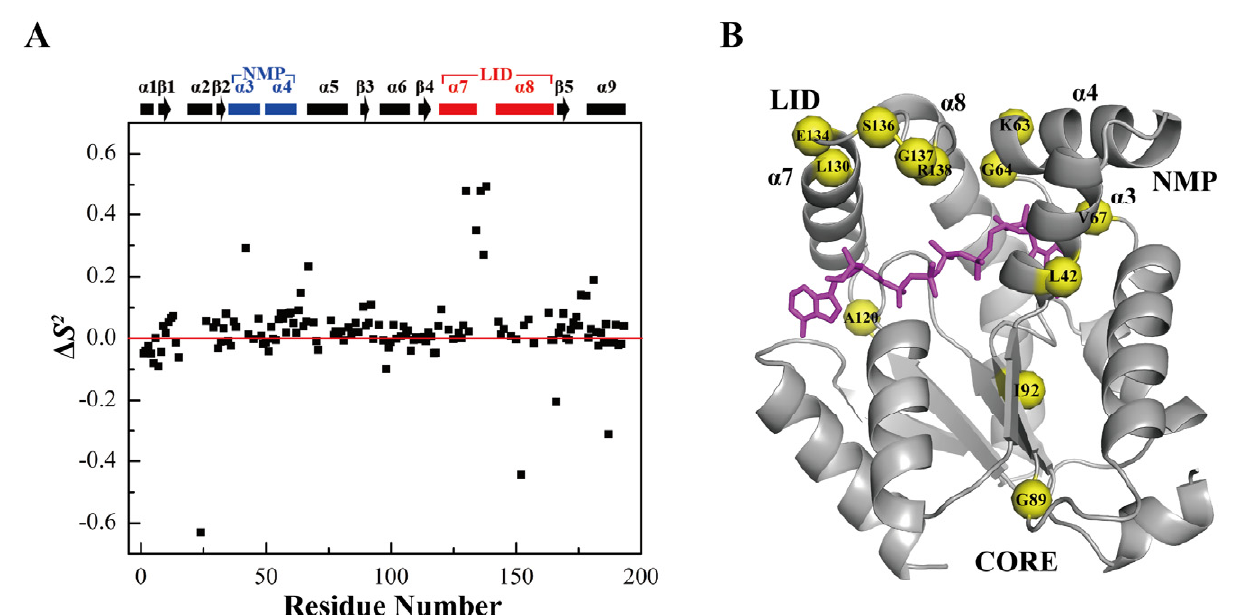
Figure 5. Comparison of the S 2 values of holo- h AK1 with apo- h AK1. ( A ) Differences of the S 2 values between holo- h AK1 and apo- h AK1. The secondary structure elements of h AK1 are displayed on the top of the figure. The α 3 α 4 in the NMP domain and α 7 α 8 in the LID domain are highlighted in blue and red, respectively. ( B ) Residues in holo- h AK1 with increased S 2 values are mapped onto the 3D structure of the h AK1-Mg 2+ -B 4 P complex.